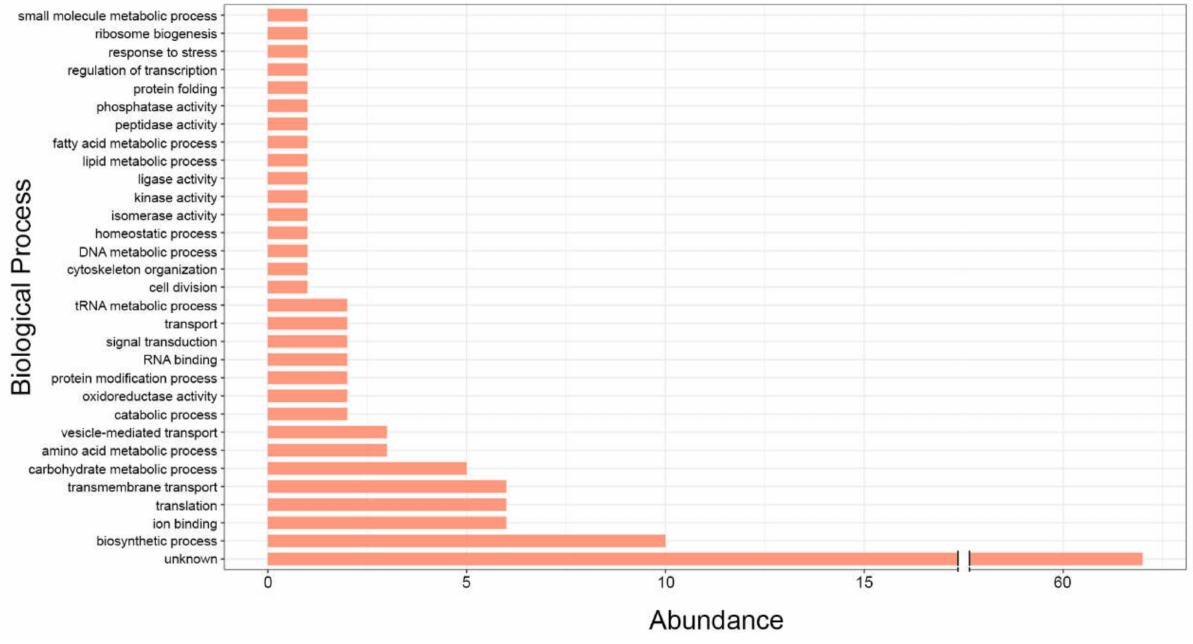
Figure 1. Functional categorization of exonic sRNAs identified in P. brasiliensis according to Gene Ontology (GO) terms within the biological process